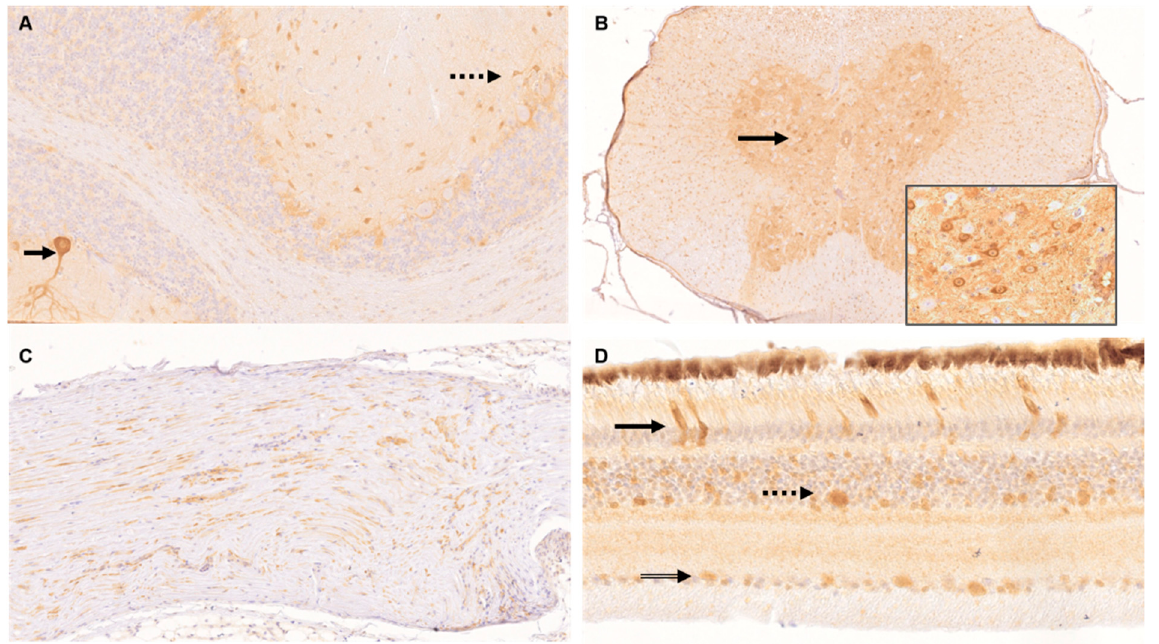
Figure 4. Immunohistochemistry (IHC) for the detection of viral antigen in nervous tissue of parrot bornavirus 4 (PaBV-4) infected adult and juvenile cockatiels. IHC was performed by using the phosphoprotein (P) antibody directed against the bornaviral phosphoprotein (P) with proven cross-reactivity against PaBV-4. ( A ) Cerebellum of juvenile cockatiel J 8. Demonstration of PaBV-4 P in a Purkinje cell with its dendrites (arrow) and neurons of the molecular layer (dashed arrow); original magnification ×200. ( B ) Spinal cord of juvenile cockatiel J 8. Demonstration of PaBV-4 P in neurons (arrow); original magnification ×100, magnification of insert ×400. ( C ) Nervus ischiadicus of adult cockatiel A 0,1. Demonstration of PaBV-4 P in single nerve fibres and endoneurium; original magnification ×200. ( D ) Retina of adult cockatiel C 0,1. Demonstration of PaBV-4 P in the photoreceptor layer (arrow), outer nuclear layer (dashed arrow) and ganglion cell layer (double lined arrow); original magnification ×400.